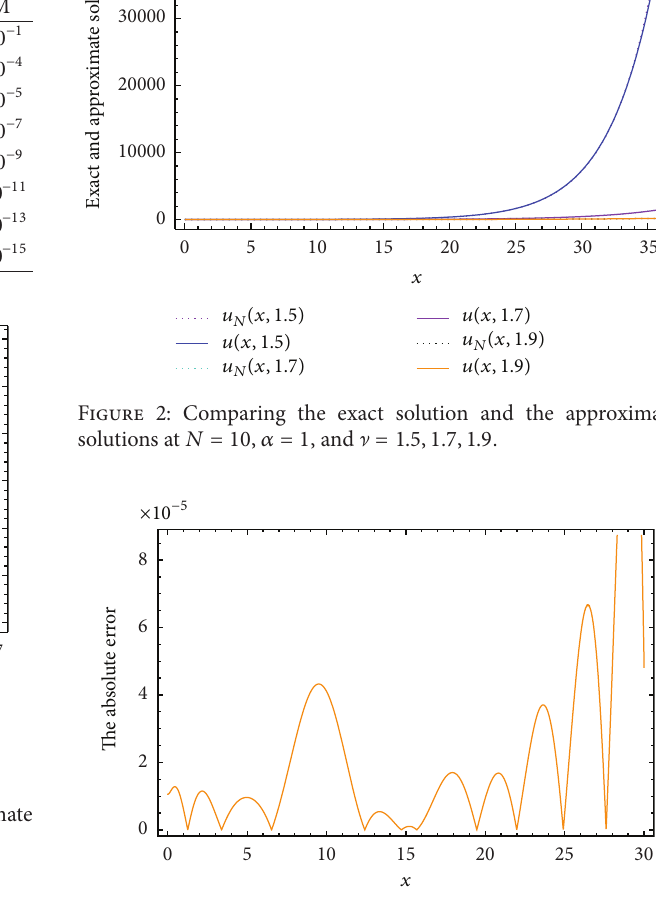
Figure 3: The absolute error for 𝛾 = 1/100 , 𝛼 = 1 at 𝑁 = 30